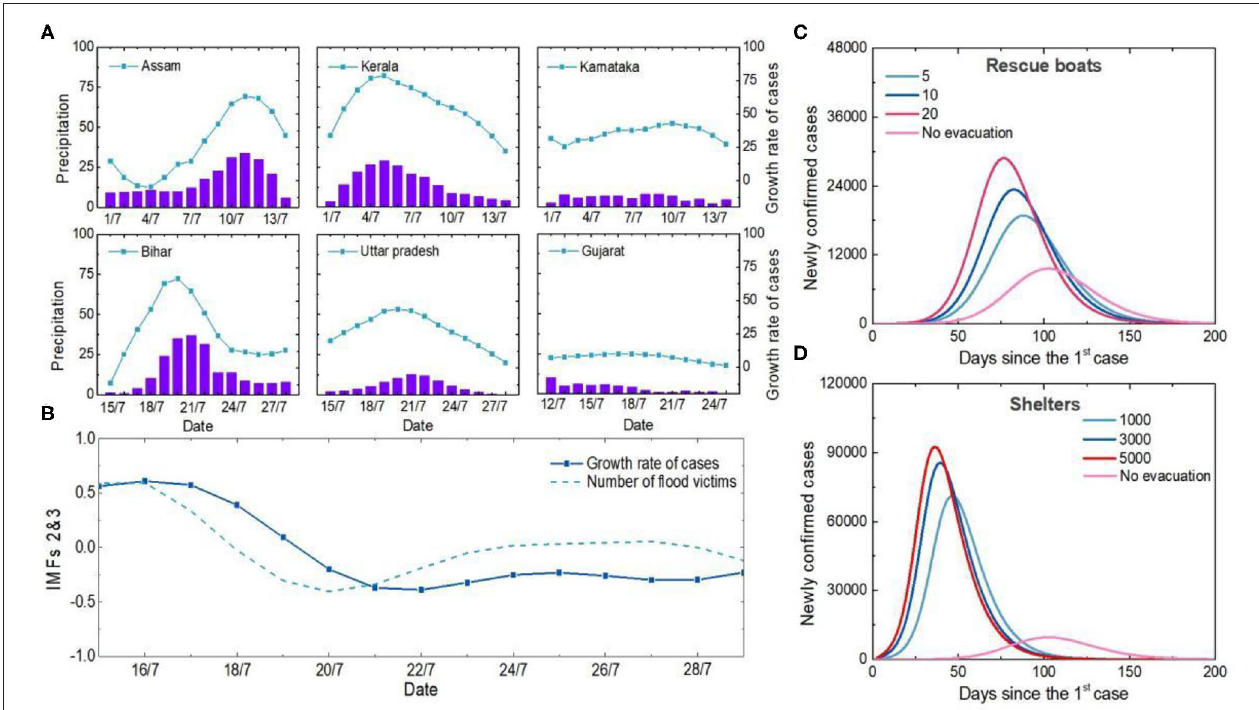
FIGURE 2 | Analysis of the causes of the first outbreak in India. (A) Temporal variations in precipitation and newly confirmed cases in Indian states. The purple column represents precipitation, and the blue symbol line represents the 5-day increase in the number of newly confirmed cases. (B) Relationship between number of flood victims and newly confirmed cases. The second and third components of the EEMD were extracted as detrending items, and all data were normalized. (C) Influences of different boat carrying capacities on the number of cases. Curves in different colors represent the simulation results of newly confirmed cases under different carrying numbers of each rescue boats. (D) Impacts of different shelter populations on the epidemic. The curves in different colors represent the simulation results of newly confirmed cases with different numbers of